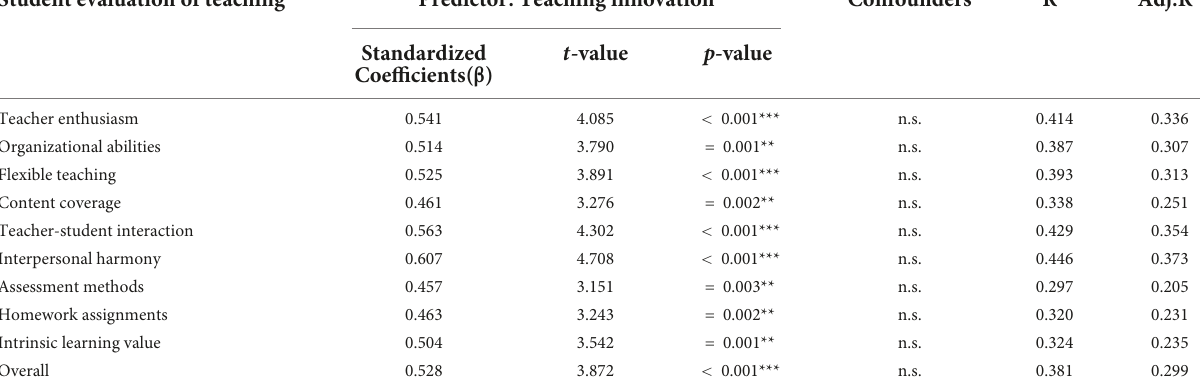
TABLE 4 Associations between teaching innovation and SET in the pre-COVID-19 pandemic period. Student evaluation of teaching